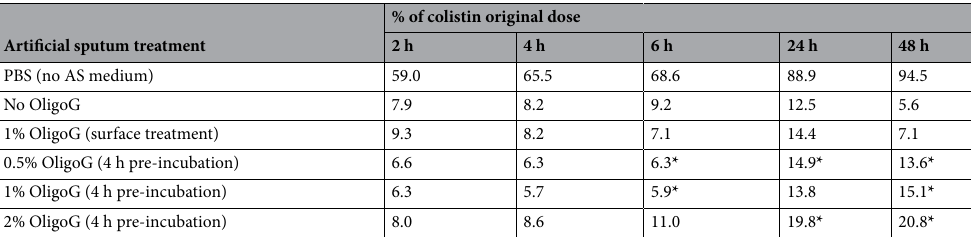
Table 1. Percentage of the original colistin dose detected in the lower Transwell compartment after 48 h diffusion through artificial sputum (AS) medium ± OligoG using a high-performance liquid chromatography- fluorescence detection method. Significant difference is indicated by *, where * p < 0.05 compared to OligoG untreated control.